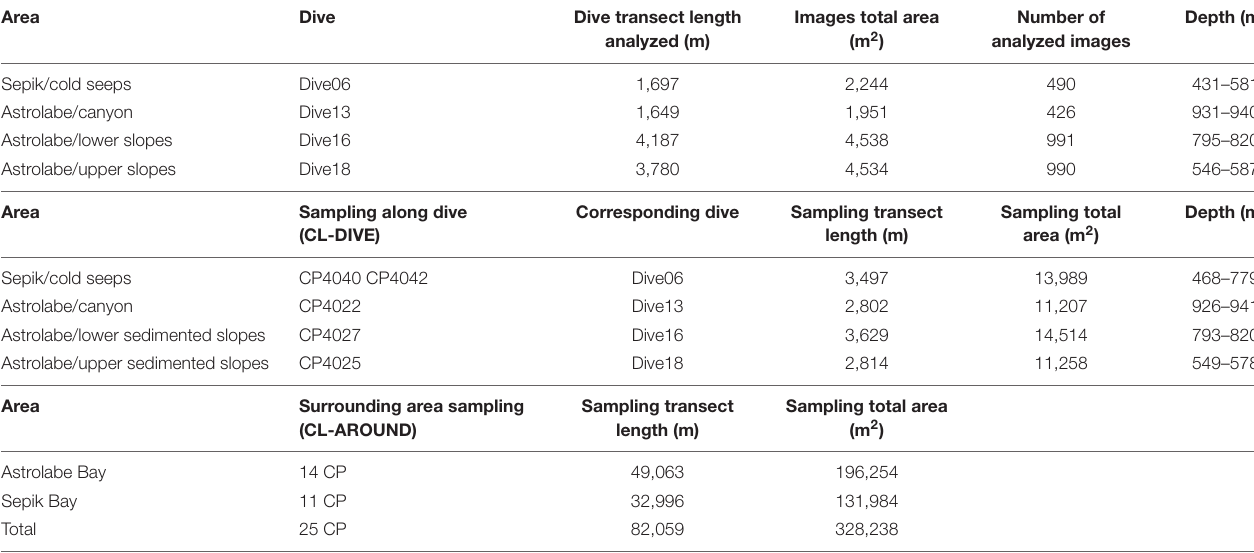
TABLE 1 | Summary of image acquisition and physical sampling efforts with sites information for the dive, sampling along dive (cl-dive) and in the surrounding area (cl-around) in the Astrolabe Bay and Sepik River area (Papua New Guinea).